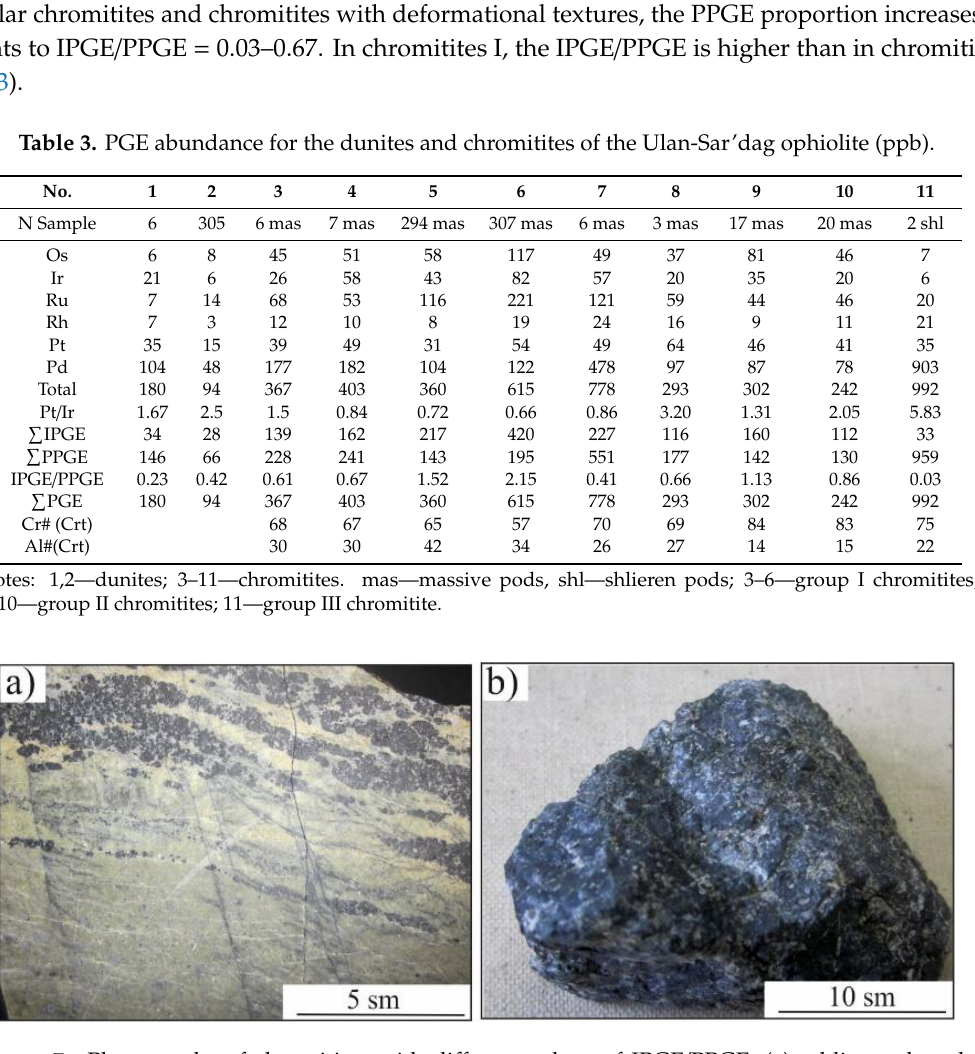
Figure 7. Photographs of chromitites with different values of IPGE/PPGE: ( a ) schlieren densely disseminates in serpentinizated dunite (∑PGE = 903ppb, and IPGE/PPGE = 0.03); ( b ) massive (∑PGE = 615 ppb, and IPGE/PPGE = 2.15).